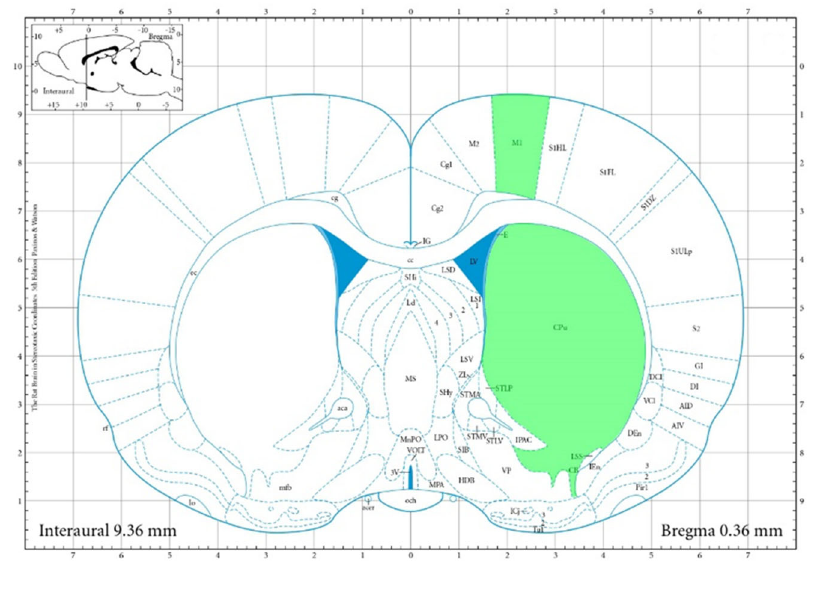
Figure 7. Areas for IHC. Areas used for IHC are highlighted in green.